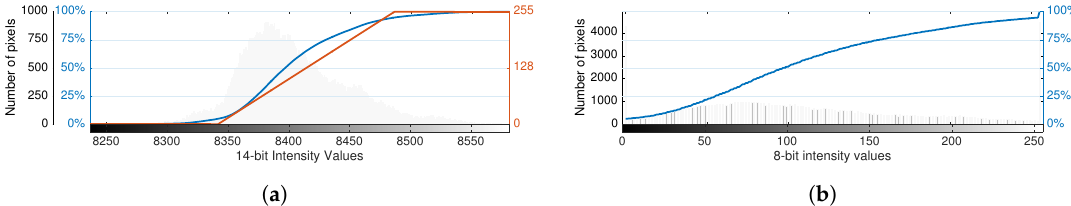
Figure 3. Automatic gain control with the linear algorithm: ( a ) the raw data histogram is used to compute the cumulative distribution function (in blue), for which a percentage of the values are clipped at the lower and upper bounds to obtain the resulting nonlinear transformation (in red); ( b ) the data are compressed through the previous transformation, resulting in the histogram for 8-bit intensity values with the corresponding cumulative distribution function (in